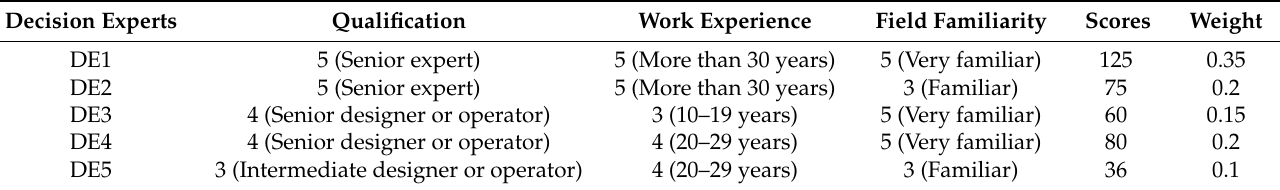
Table 6. Determination of expert